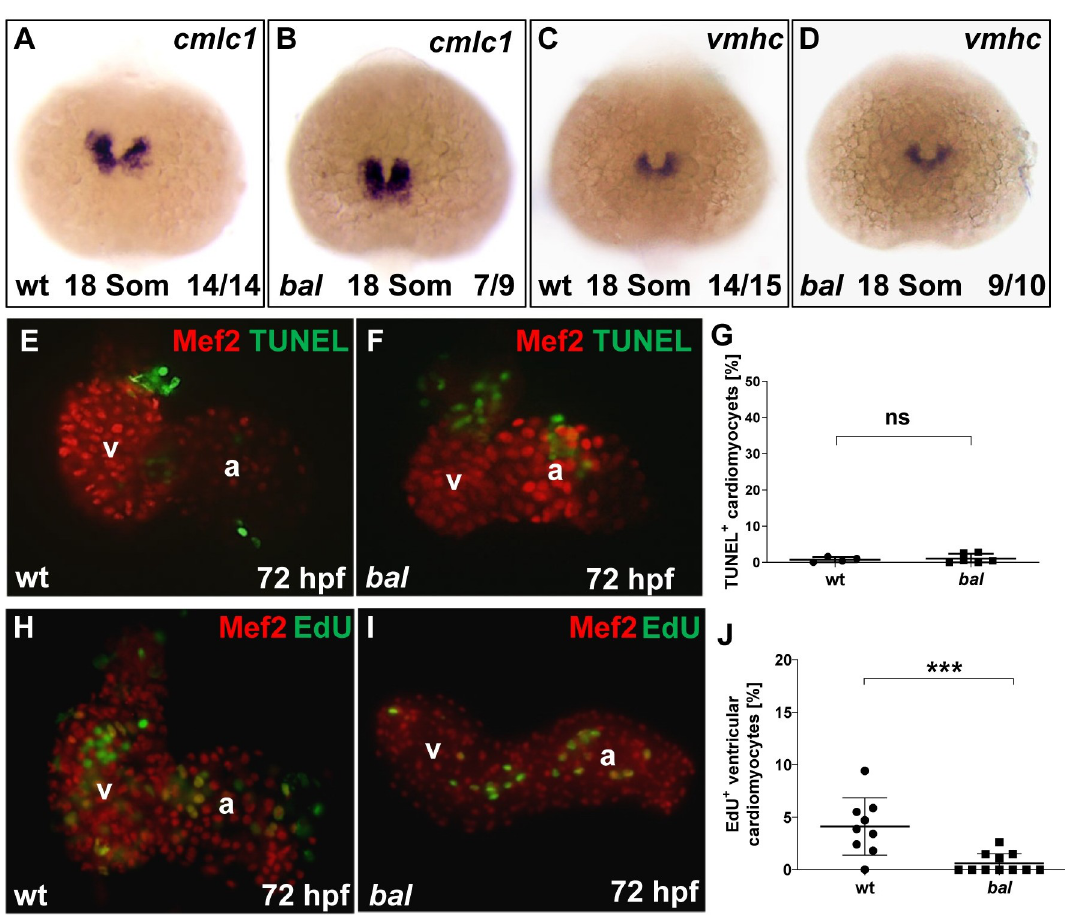
Fig 2. Early progenitor and chamber specification proceed normally in bal mutants. (A-D) Whole-mount antisense RNA in situ hybridization (ISH) of cmlc1 and vmhc showed similar expression in bal mutants and wt siblings. (E, F) TUNEL staining (green) and IF for Mef2 (red) on dissected wt (E) and bal mutant hearts (F). (G) Quantification of TUNEL + CMs revealed no alterations in apoptosis (wt 0.75 ± 0.70%, n = 4, bal 1.07 ± 1.28%, n = 6, p = 0.92), error bars indicate s.d., ns, not significant. (H, I) IF against Mef2 (red) and EdU (green) on dissected wt and bal hearts showed decreased numbers of EdU + ventricular CMs. (J) Quantification revealed significantly decreased levels of EdU + ventricular CMs in bal mutant hearts (wt 4.10 ± 2.73, n = 9, bal 0.61 ± 0.92, n = 11, p = 0.001). For significance testing Mann-Whitney-U test was applied, error bars indicate s.d., ��� p < 0.001, ns, not significant.